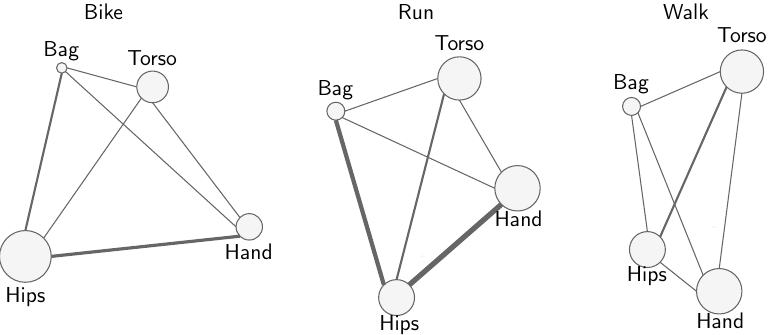
Figure 21. Estimated interaction structure of the data sources for 3 different activities (bike, run, and walk), using the fANOVA graph [116]. Data sources are grouped by their respective positions. The circumference of the circles represents main effects (importance), and the thickness of the edges represents total interaction effects. From